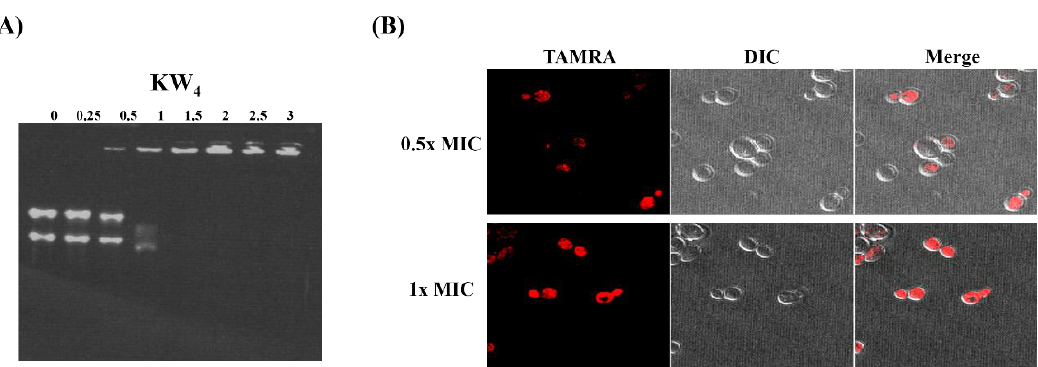
Figure 8. Morphological analysis of C. albicans and RNA binding of the KW 4 peptide. The concentrations of KW 4 range from 2.5 to 30 µg for this assay in order to create a different ratio with a fixed amount (10 µg) of RNA. ( A ) Gel retardation assay showing peptide binding to RNA obtained from C. albicans, the numbers above the figure indicate the ratio of the peptide and RNA concentrations. ( B ) Confocal laser-scanning microscopy (CLSM) images of C. albicans incubated with rhodamine-labeled KW 4 . The cells were incubated with 0.5× or 1× MIC for 10 min in PBS buffer. TAMRA (5-carboxytetra methyl rhodamine) and DIC (differential interference contrast microscopy) were merged in the right panel.